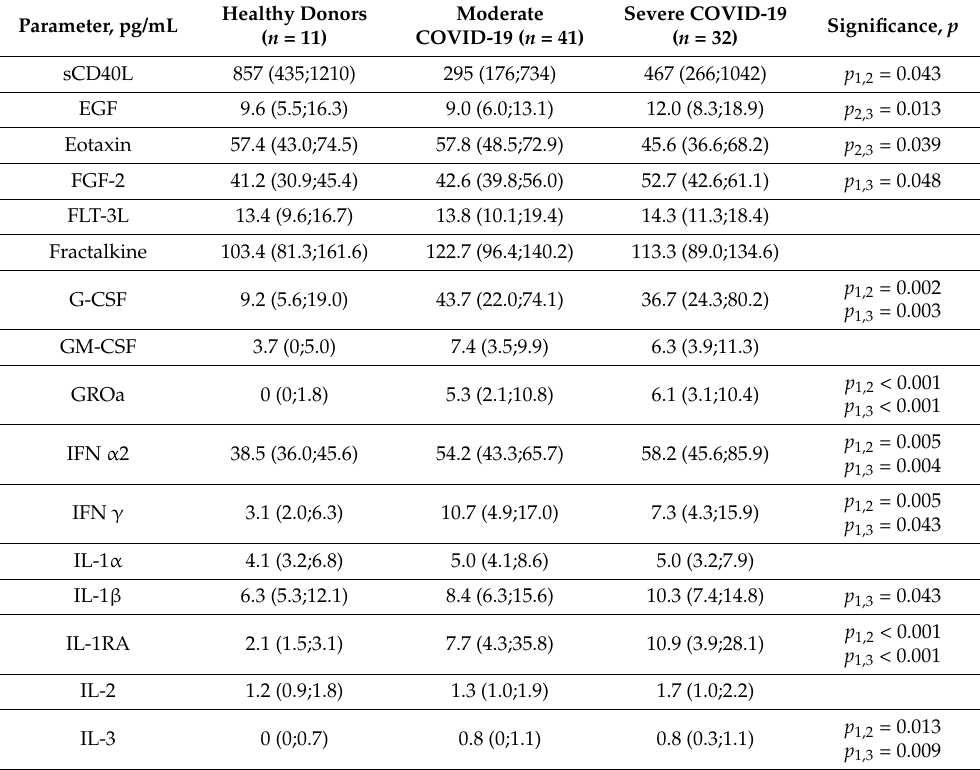
Table 1. Plasma levels of cytokines in patients with moderate or severe COVID-19 and healthy donors, Me